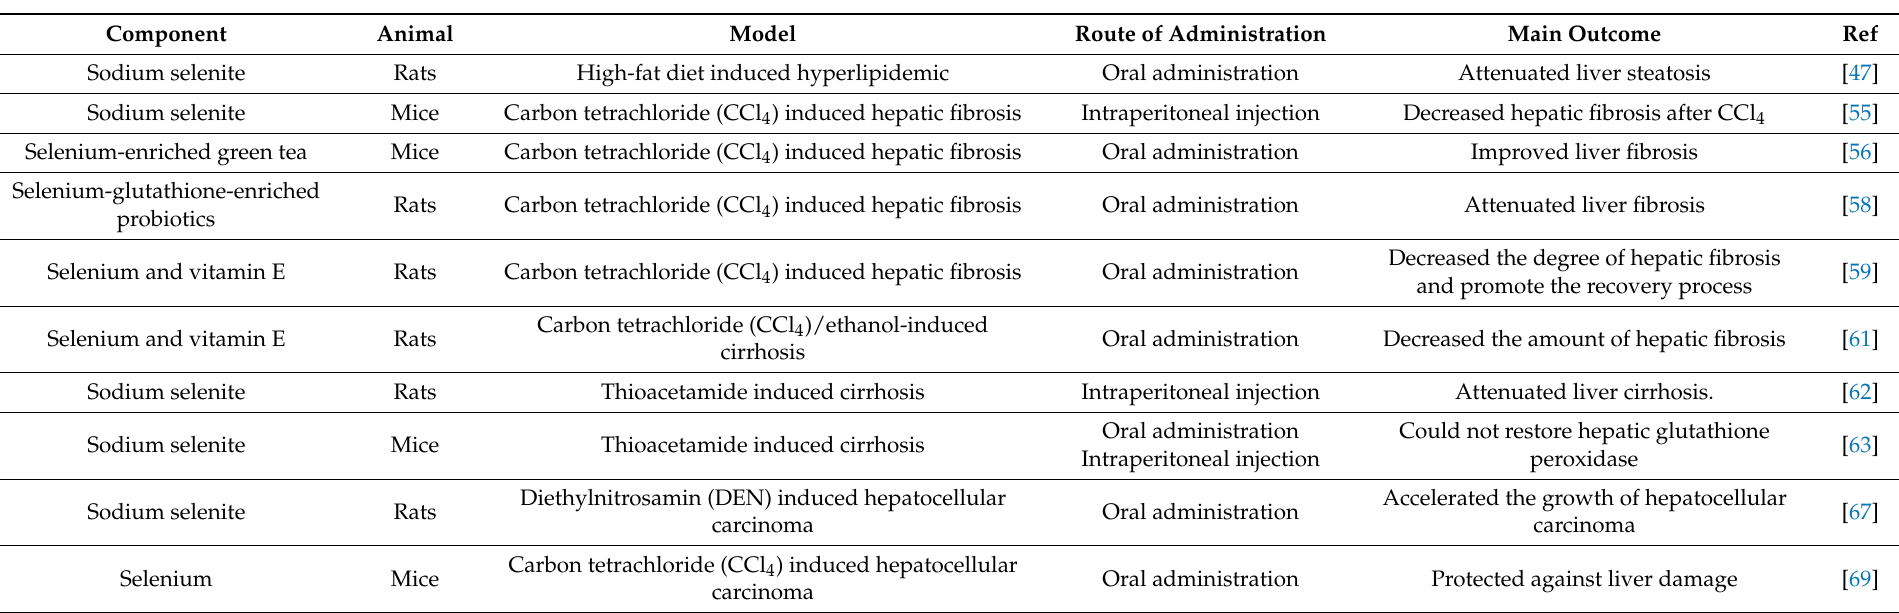
Table 1. The role of selenium in animal